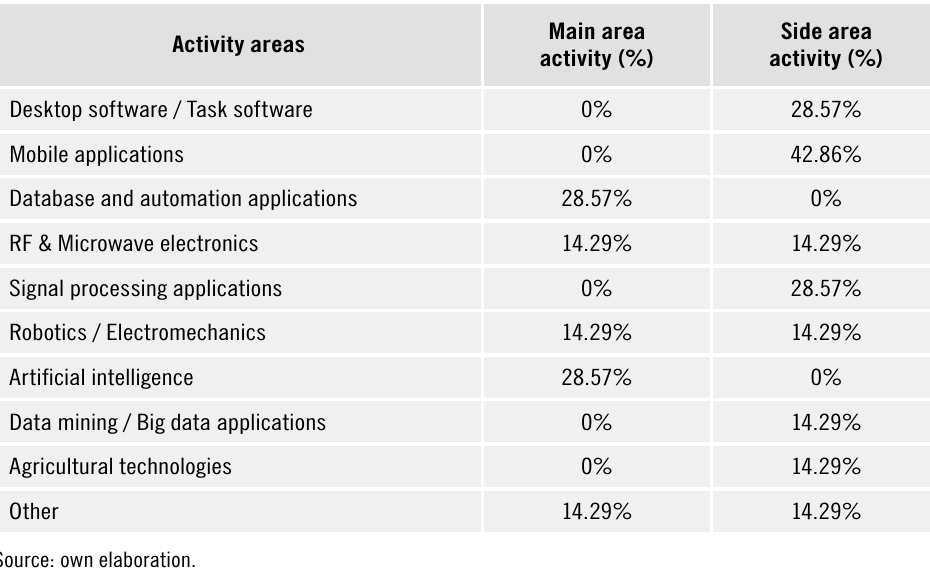
Table 1. Results of activity areas of the respondent companies